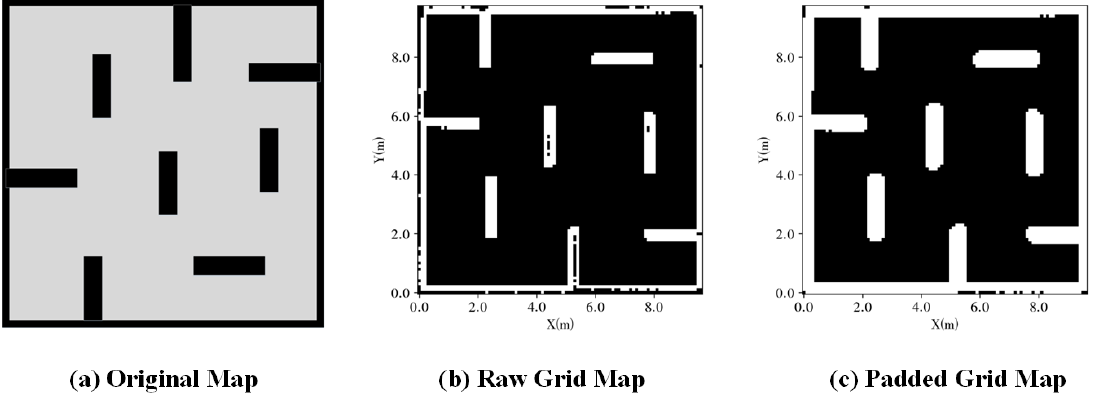
Figure 5. Grid Map Padding.